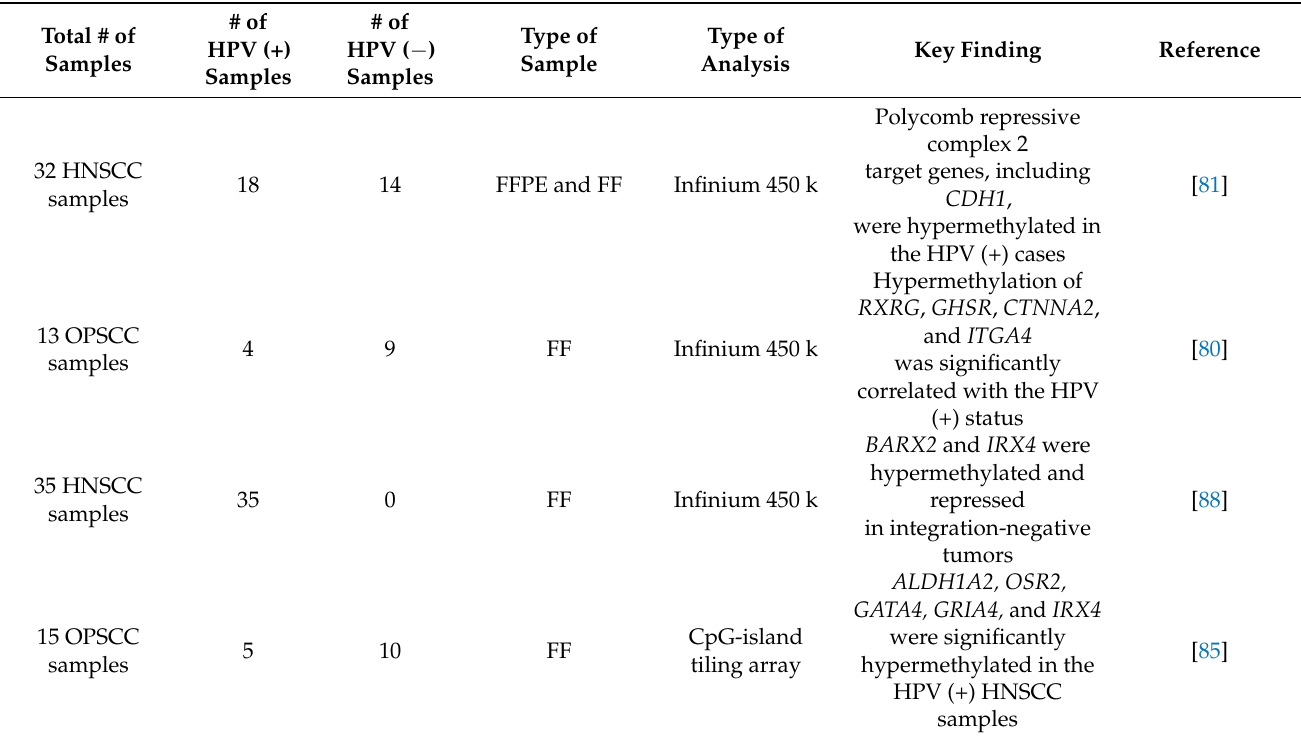
FFPE: Formalin-fixed paraffin-embedded, FF: fresh